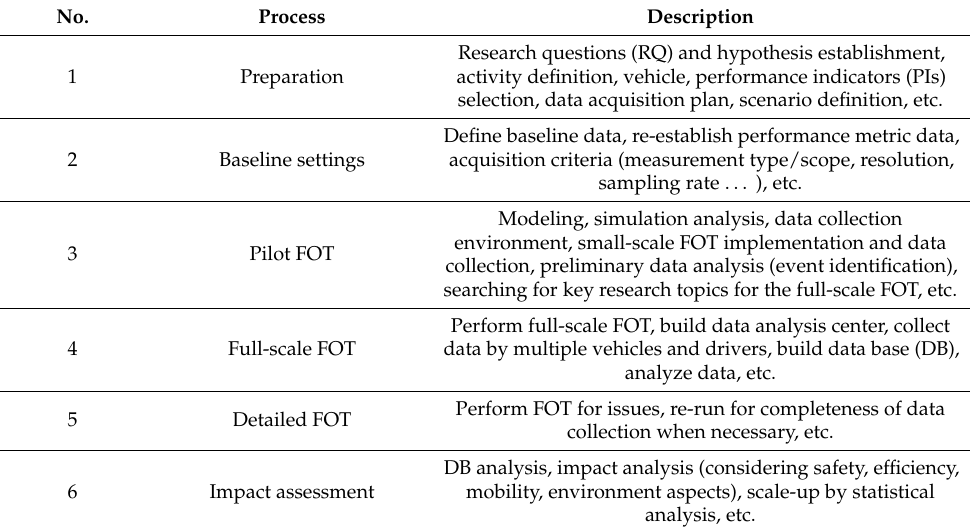
Table 1. Overall procedure of FOT for autonomous vehicles. No. Process Description Research questions (RQ) and hypothesis establishment, activity definition, vehicle, performance indicators (PIs) 1 Preparation selection, data acquisition plan, scenario definition, etc. Define baseline data, re-establish performance metric data, Baseline settings acquisition criteria (measurement type/scope, resolution, sampling rate . . . ), etc. Modeling, simulation analysis, data collection environment, small-scale FOT implementation and data Pilot FOT collection, preliminary data analysis (event identification), searching for key research topics for the full-scale FOT, etc. Perform full-scale FOT, build data analysis center, collect Full-scale FOT data by multiple vehicles and drivers, build data base (DB), analyze data,